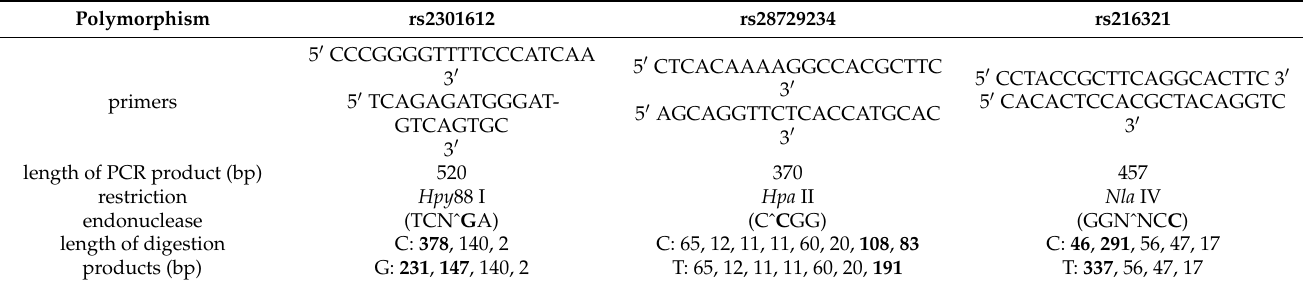
Table 1. PCR–RFLP based genotyping of the ADAMTS13 rs2301612, rs28729234, and vWF rs216321 SNPs. “ˆ” indicates the cleavage site in the recognition sequence of the restriction endonucleases. SNPs are printed in bold. Lengths of digestion products shown in bold are the allele-specific fragments; normal typesetting refers to control